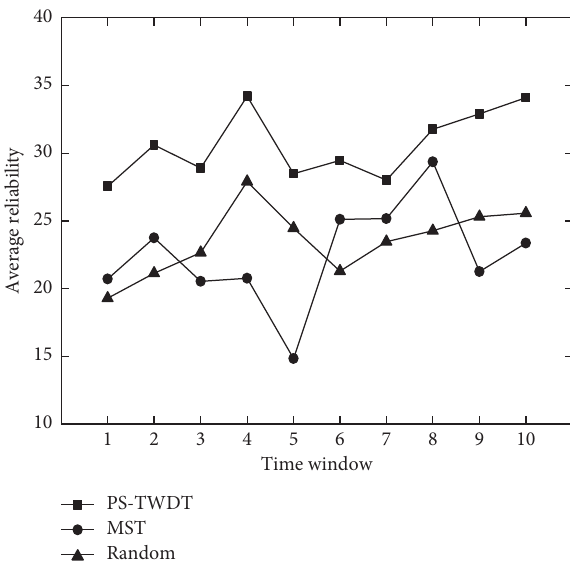
Figure 9: Average data benefit.